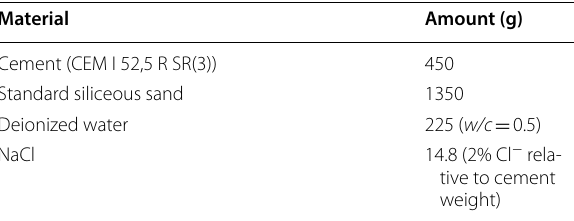
Table 1 Composition of mortar specimens.